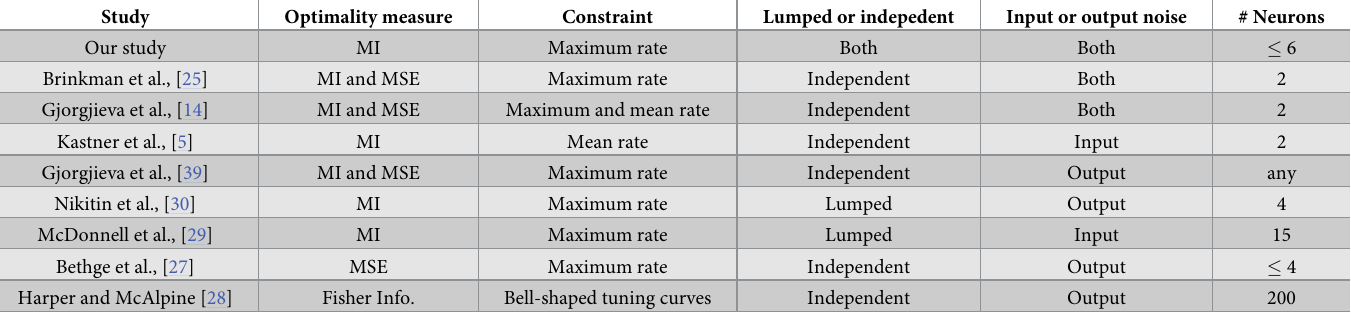
Table 2. Comparison of different studies with regards to the different optimization measures, constraints, information convergence strategies, sources of noise and neuronal population size. MI stands for Mutual Information and MSE for Mean Square